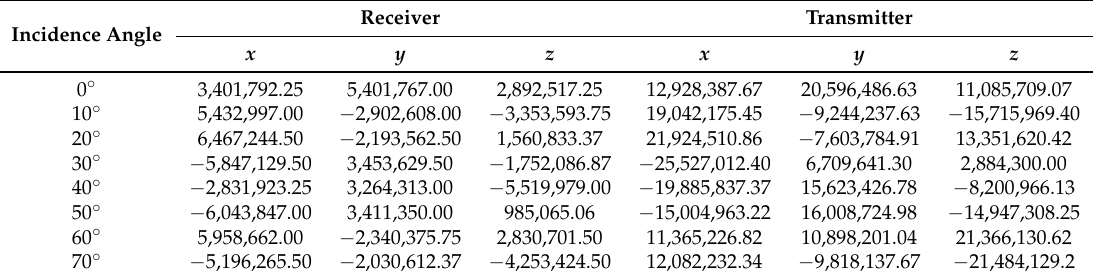
Table A1. Receiver and transmitter satellite coordinates (m) in the Earth-centered Earth-fixed (ECEF) system.